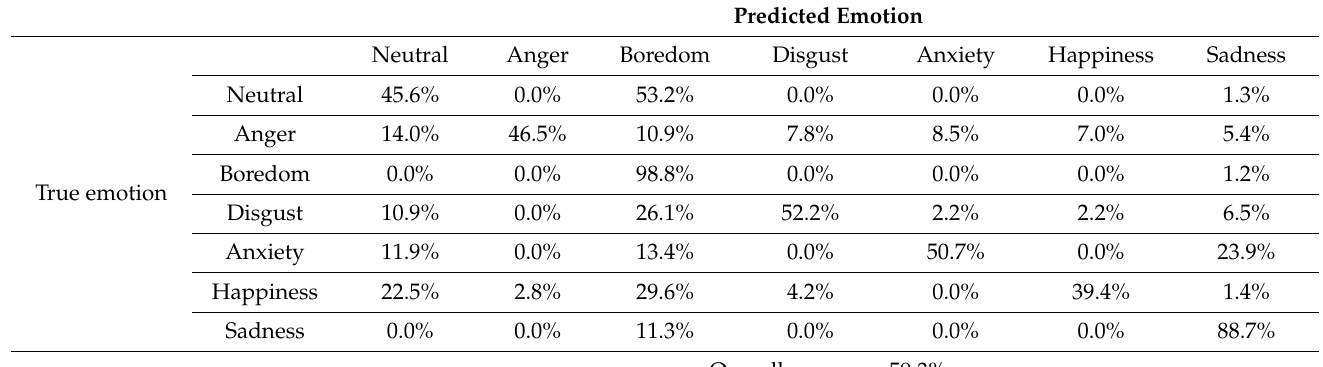
Table 13. Confusion matrix of the emotion classification results of the proposed cascaded DnCNN–CNN that was trained on the German EMO-DB mixed with the PSTATION